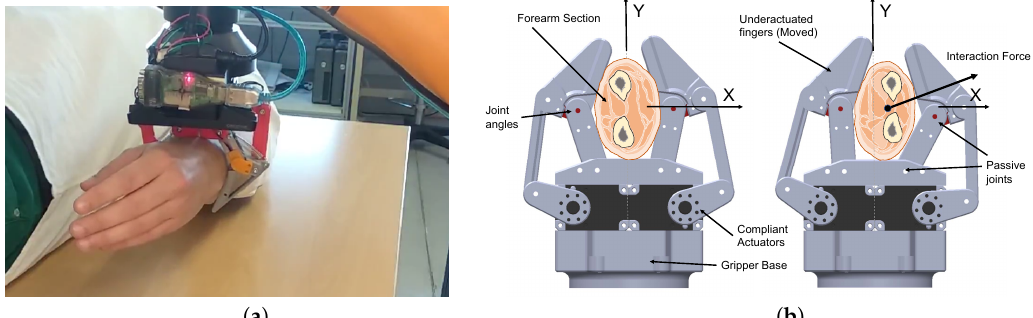
Figure 1. The proposed approach estimates the forces applied by a human in a frontal plane when the forearm is grasped by a robot ( a ) with an underactuated gripper using only the proprioceptive information from servos and passive joint angles ( b ).